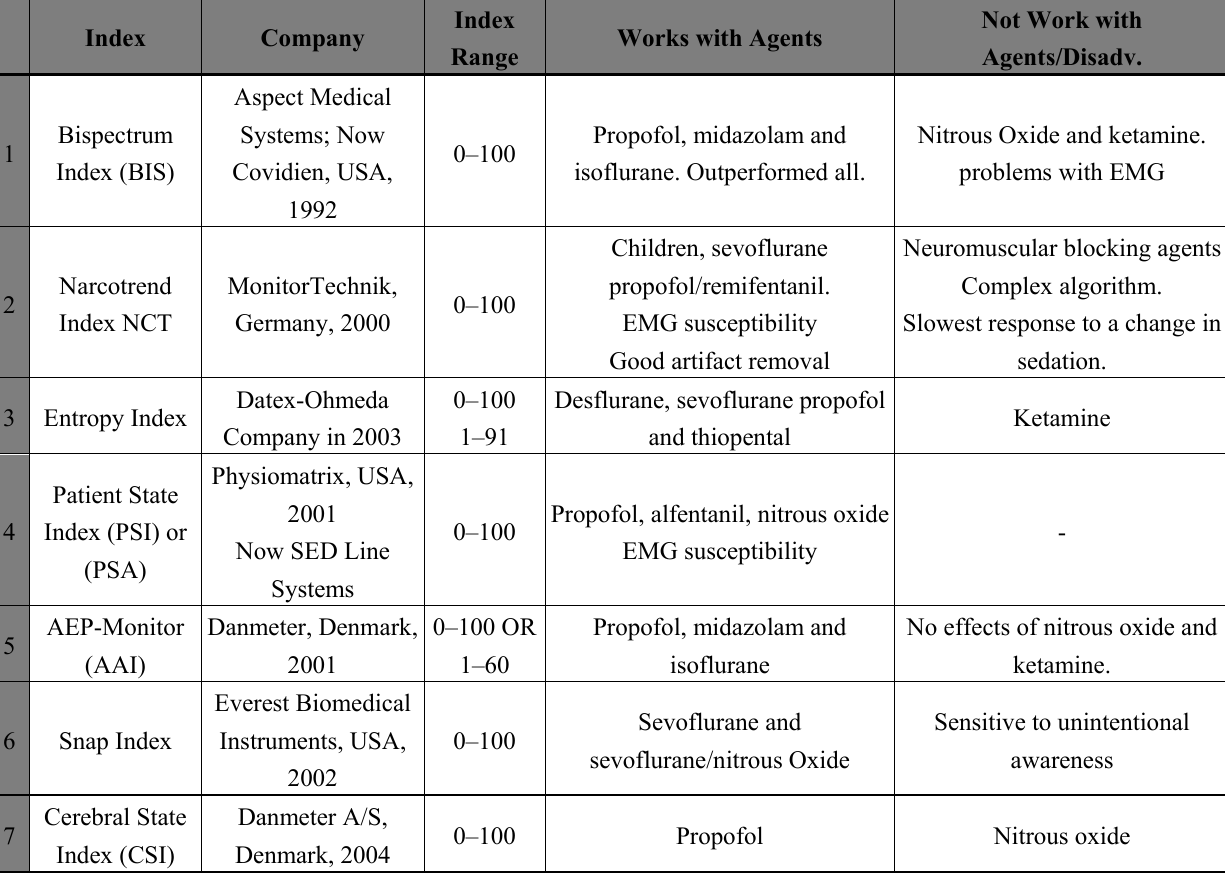
Table 3. The most common indexes used to monitor the depth of